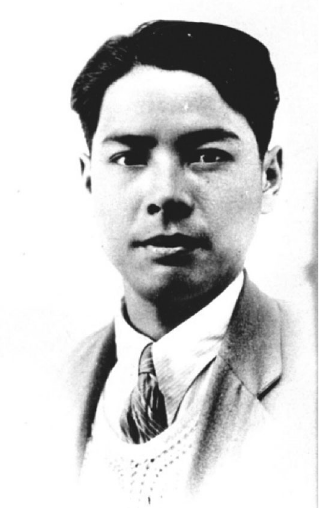
Figure 2. Mr. Xitao Cai (1933).